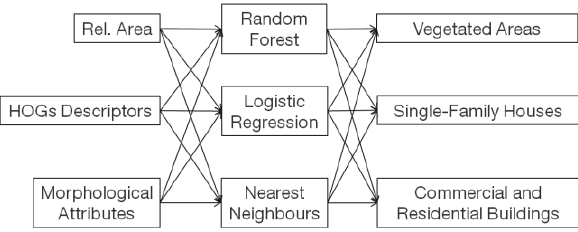
Figure 3. Ensemble of soft classifiers used for our experiments. Each group of attributes was submitted to each of the classifiers adding to a total of nine output membership values for each class and for each